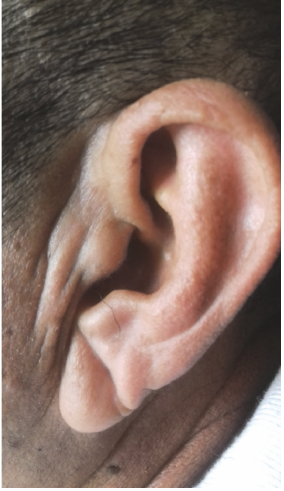
Figure 1: Diagonal earlobe crease in an Atahualpa